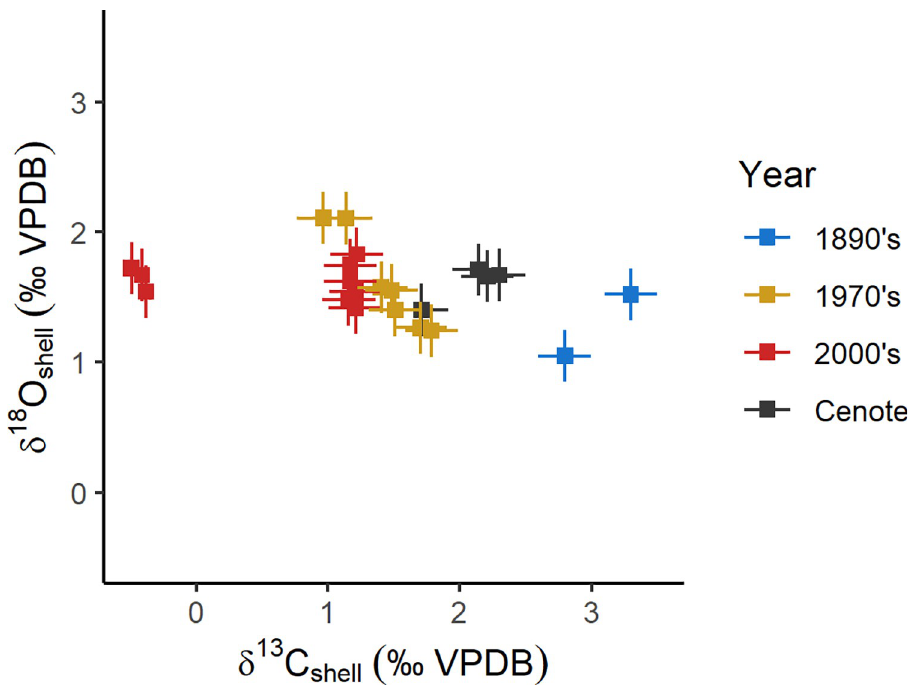
Fig 5. Crossplot of carbon and oxygen isotope values measured on shell carbonate. Error bars are 2 standard deviation instrumental